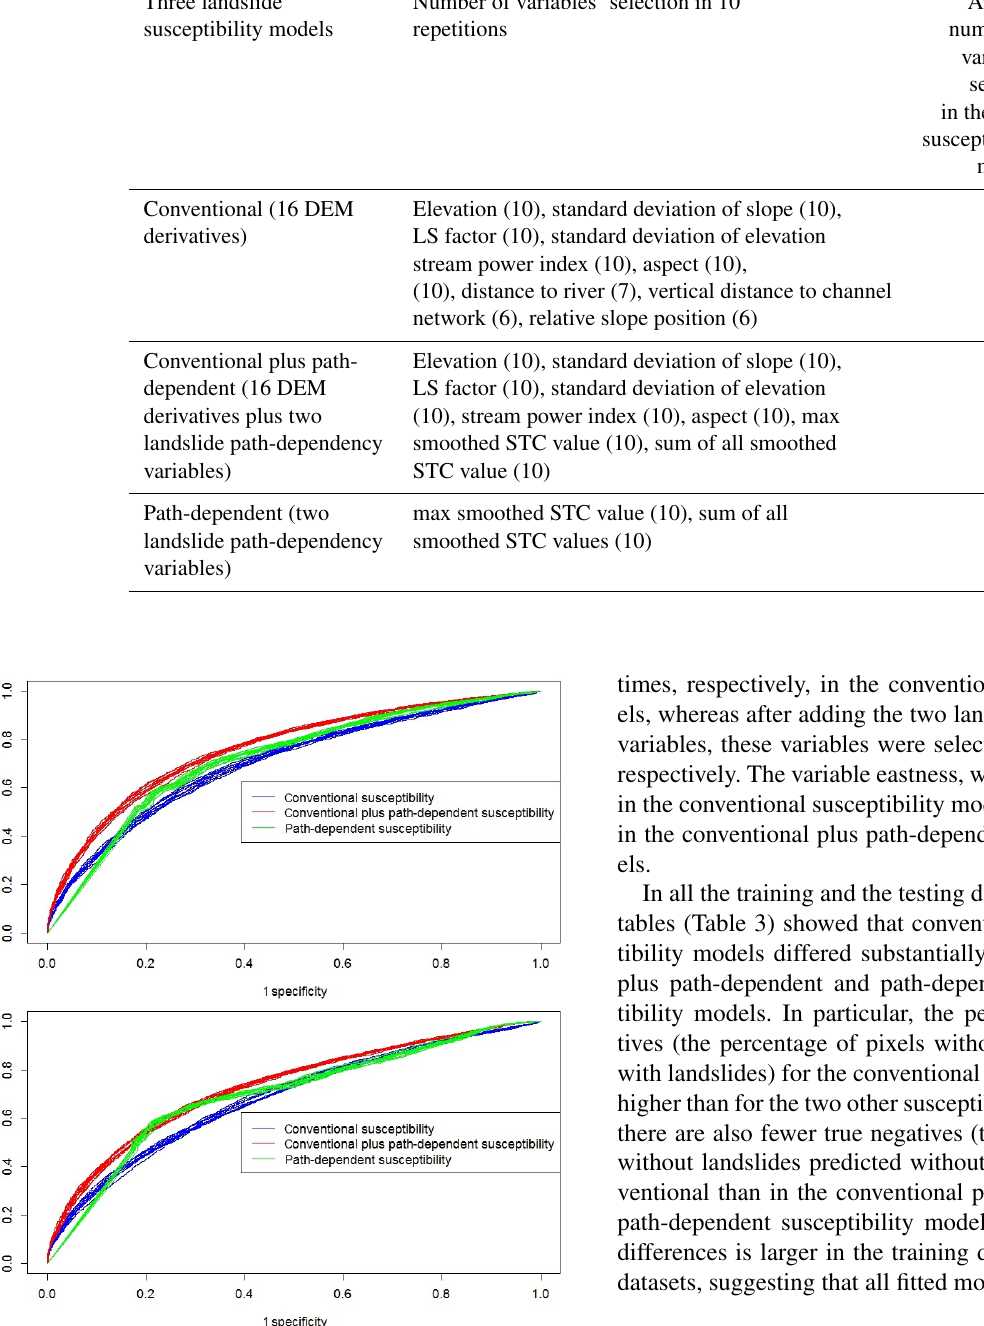
Figure 7. Receiver operating characteristic (ROC) curves of the three landslide susceptibility models in the 10 training datasets (left) and in the 10 testing